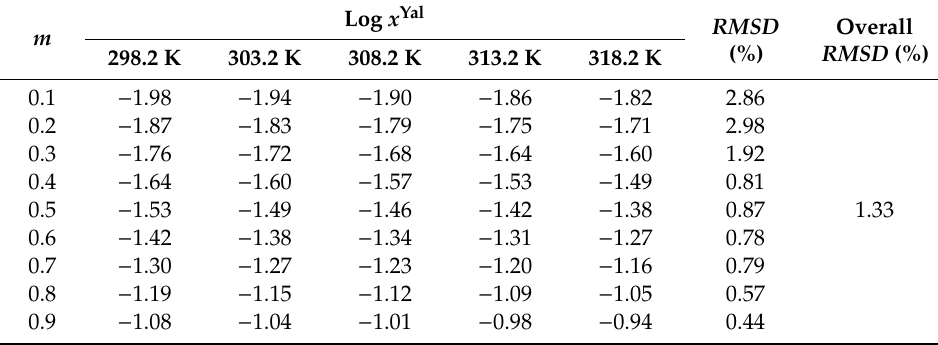
Table 7. Log x Yal values of ECT obtained by the “Yalkowsky-Roseman” model in various “PEG-400 + water” combinations ( m ) at “ T = 298.2 to 318.2